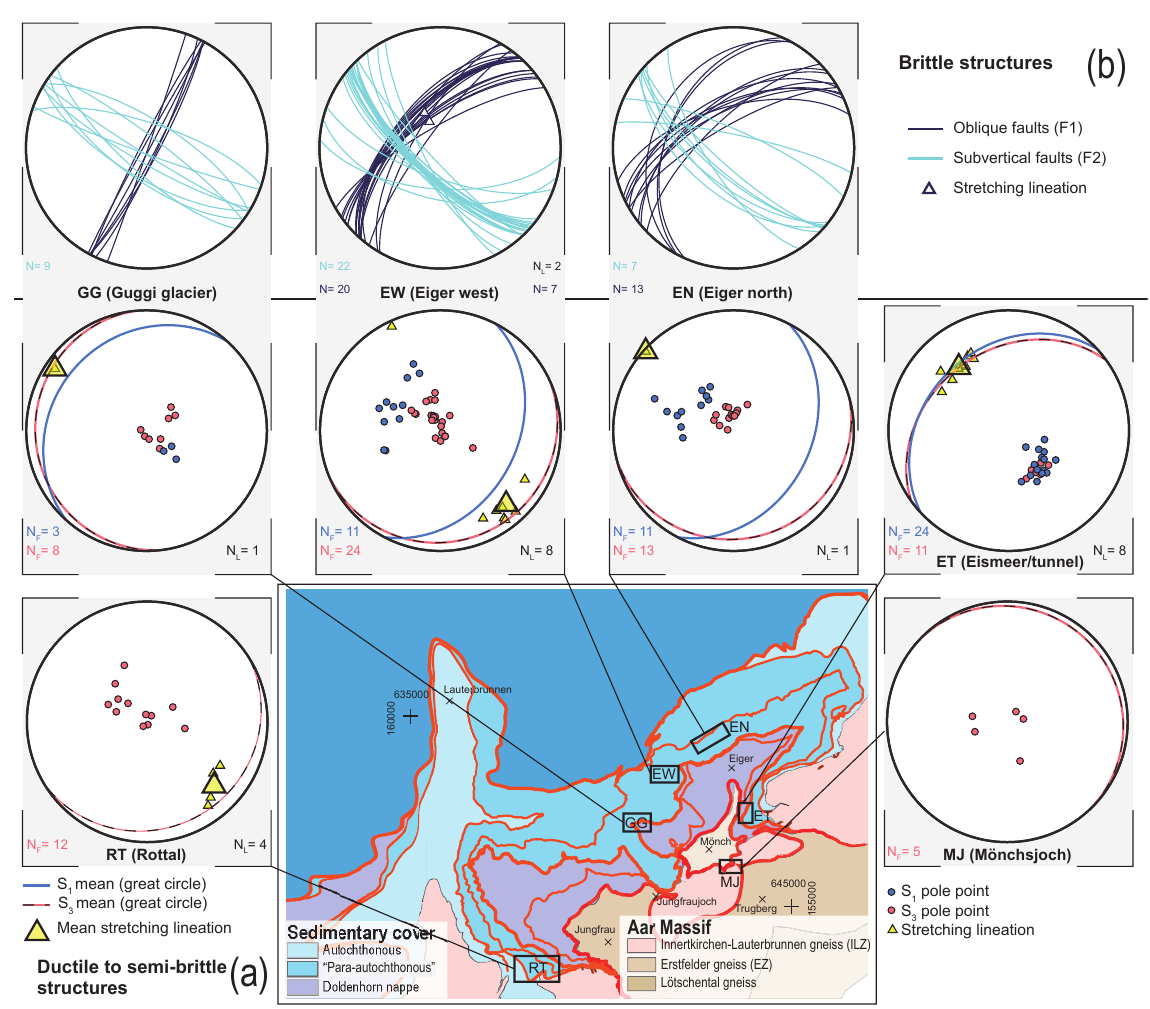
Figure 9. Deformation structures in the sediments. (a) Bedding parallel S1 foliation and later induced S3 foliation that consists of numerous slip surfaces. Stretching lineation is only documented on S3 surfaces. (b) Brittle-only structures that cross-cut structures in panel (a) .